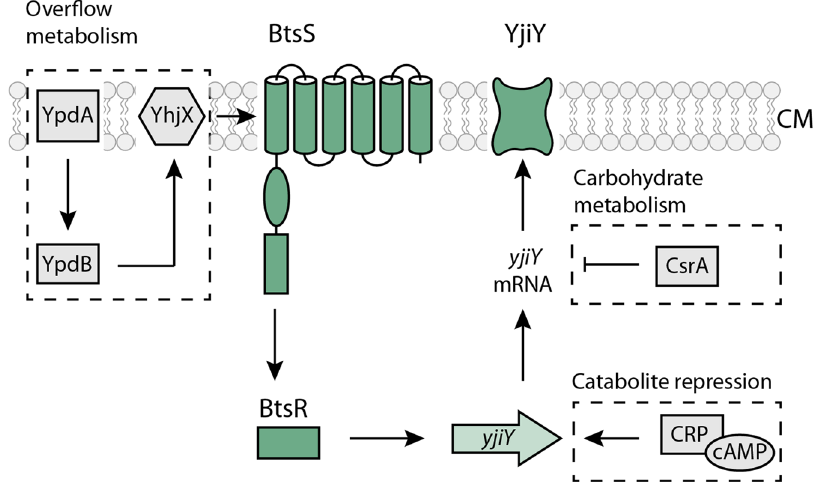
Figure 1. Schematic depiction of the BtsS/BtsR (YehU/YehT) system in Escherichia coli . The scheme summarizes the regulatory network associated with signal transduction by the BtsS/BtsR two-component system, the influence of two-component system YpdA/YpdB and the global regulators CsrA and CRP. Membrane proteins are integrated in the cytoplasmic membrane (CM). Activating ( ↑ ) and inhibitory ( ⊥ ) effects are indicated. See text for